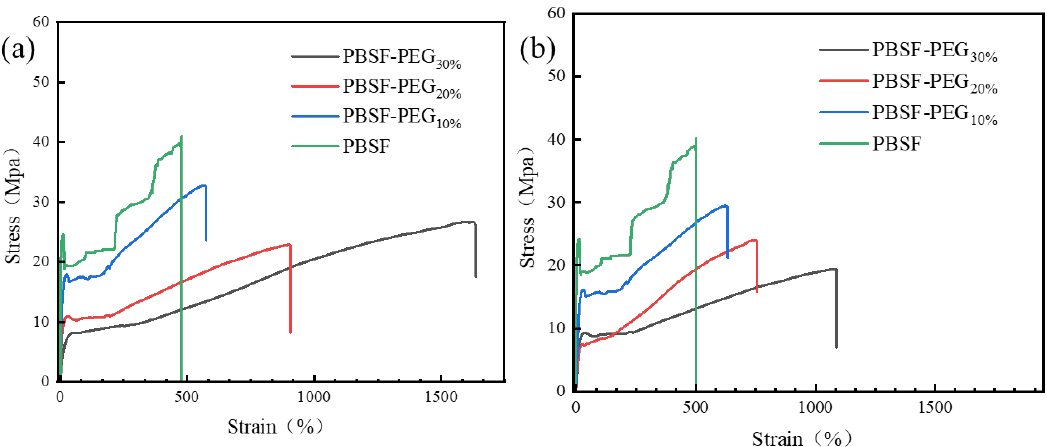
Figure 10. The representative stress – strain characteristics for the dry ( a ) and swollen ( b ) PBSF and PBSF-PEG. Table 4. Mechanical characterization date of the dry and swollen PBSF and PBSF-PEG copolymers.